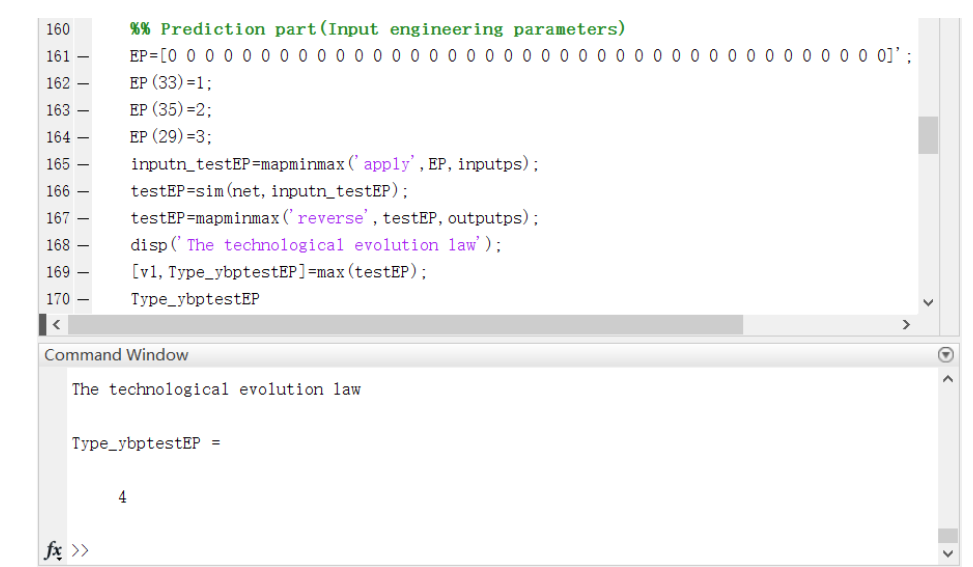
Figure 10. Prediction of the technological evolution law.